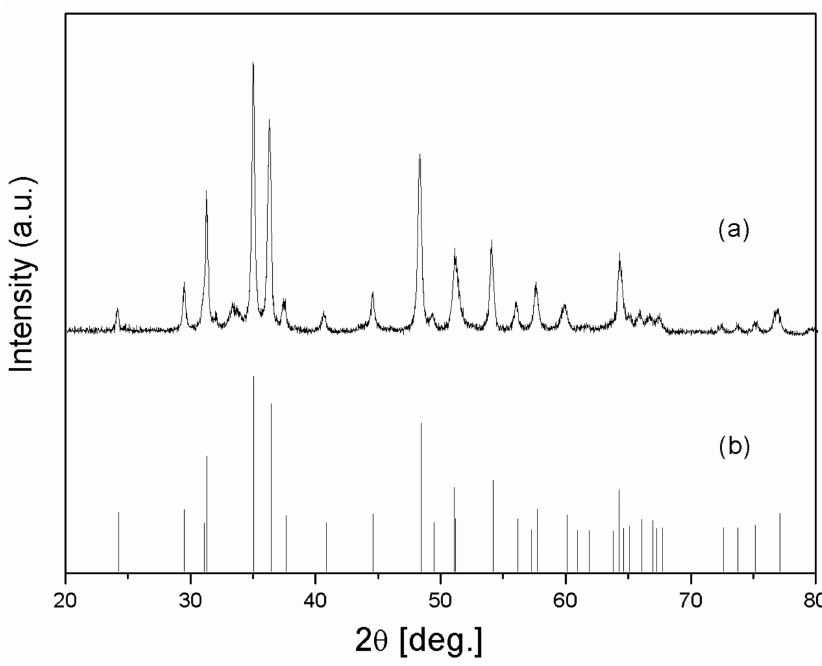
Figure 1. X-ray di ff raction spectra (XRD) of ( a ) Fe x Se y , which is the black solid synthesized from the reaction of FeCl 3 , SeO 2 in the presence of methanolic Py solution under CO pressure, and ( b ) standard pattern of ferroselite FeSe 2